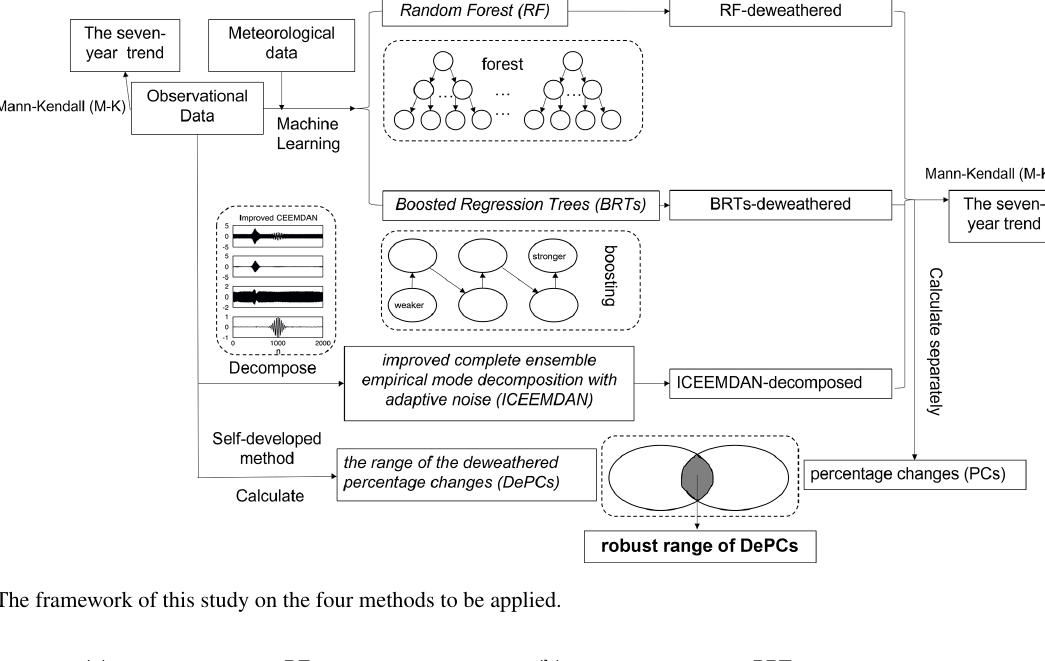
Figure 2. The framework of this study on the four methods to be applied.